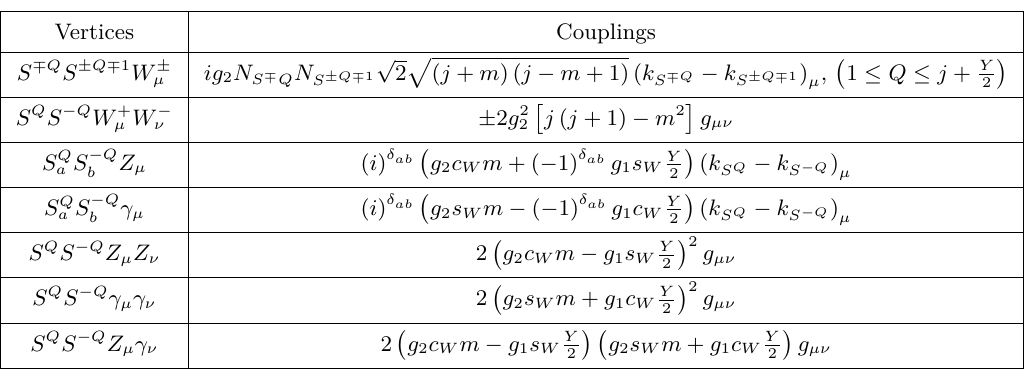
Table 3. Gauge Feynman rules for the EW scalar